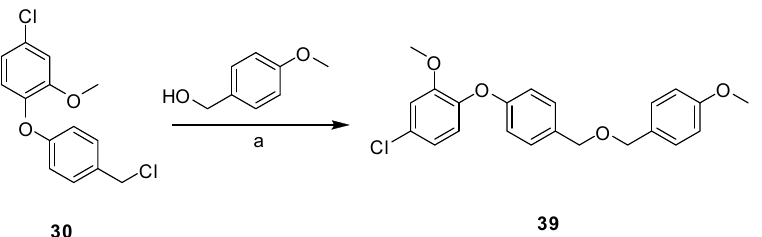
Scheme 6. Synthesis of di -triclosan derivative 39. Reagents and conditions : ( a ) NaH, DMF, r.t. to 0 °C to r.t., 4.5 h, 67%.